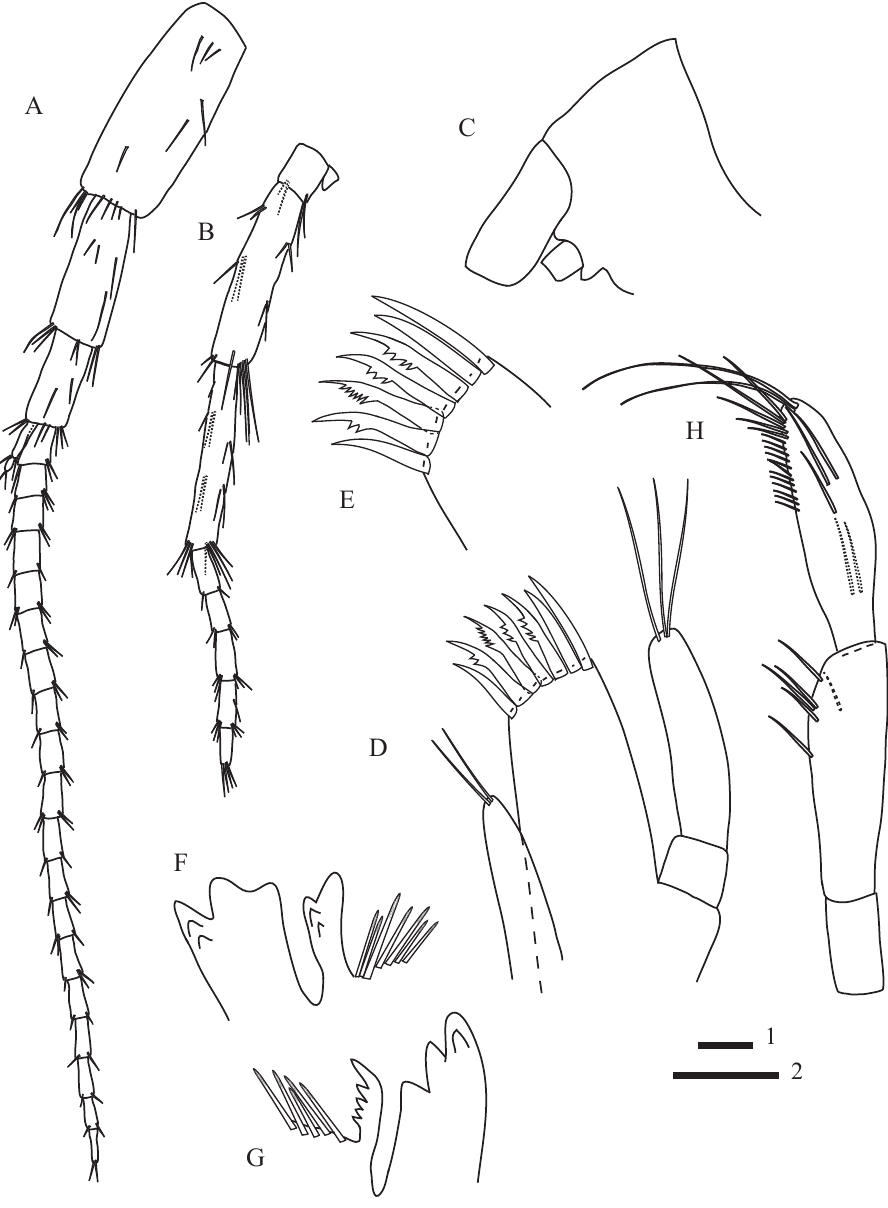
Figure 2. Niphargus hakani sp. n., male 9 mm (holotype, ZCRU Amph.1010). A Antenna I B Antenna II C Head D–E Maxilla I F Left mandible. G Right mandible. H Mandibular palp. Scale bars: 1=0.25 mm ( F–G ). 2=0.5 mm ( C–E, H ). 3=1mm ( A–B